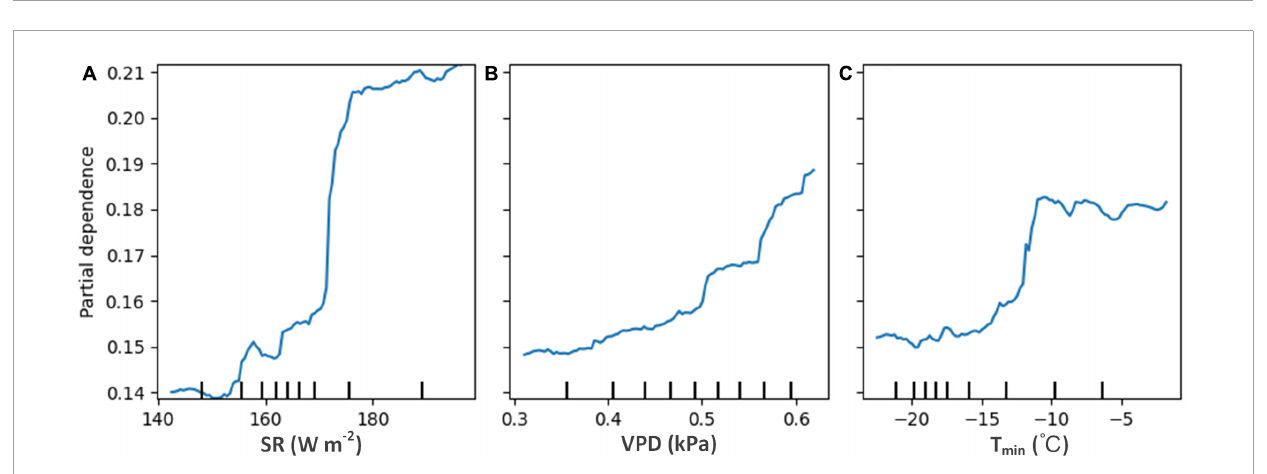
FIGURE5 Partial dependence plots for the three most influential variables in the model for long-term AC1. (A) For solar radiation (SR), (B) for vapor pressure deficit (VPD), and (C) for minimum temperature (T min ).